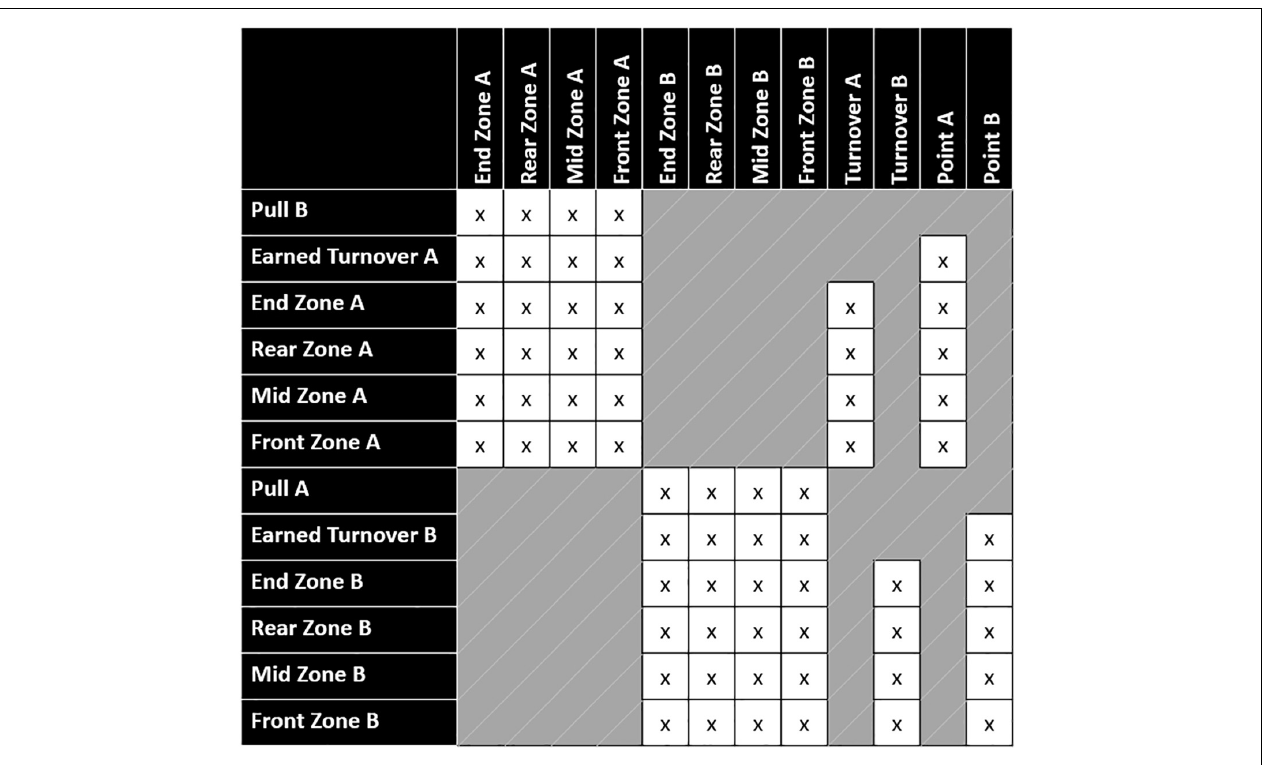
FIGURE 3 | State transition matrix for all the possible transition probabilities (x) between the starting states, transient states, and absorbing